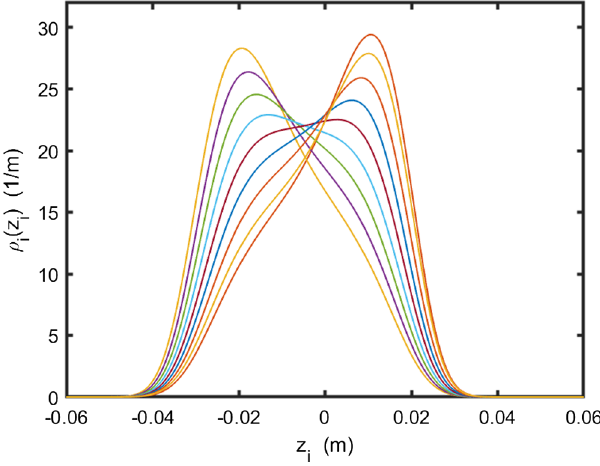
FIG. 13. Wake potential (pseudo — Green function) for the ALS-U storage ring, computed with a 1 mm driving bunch.